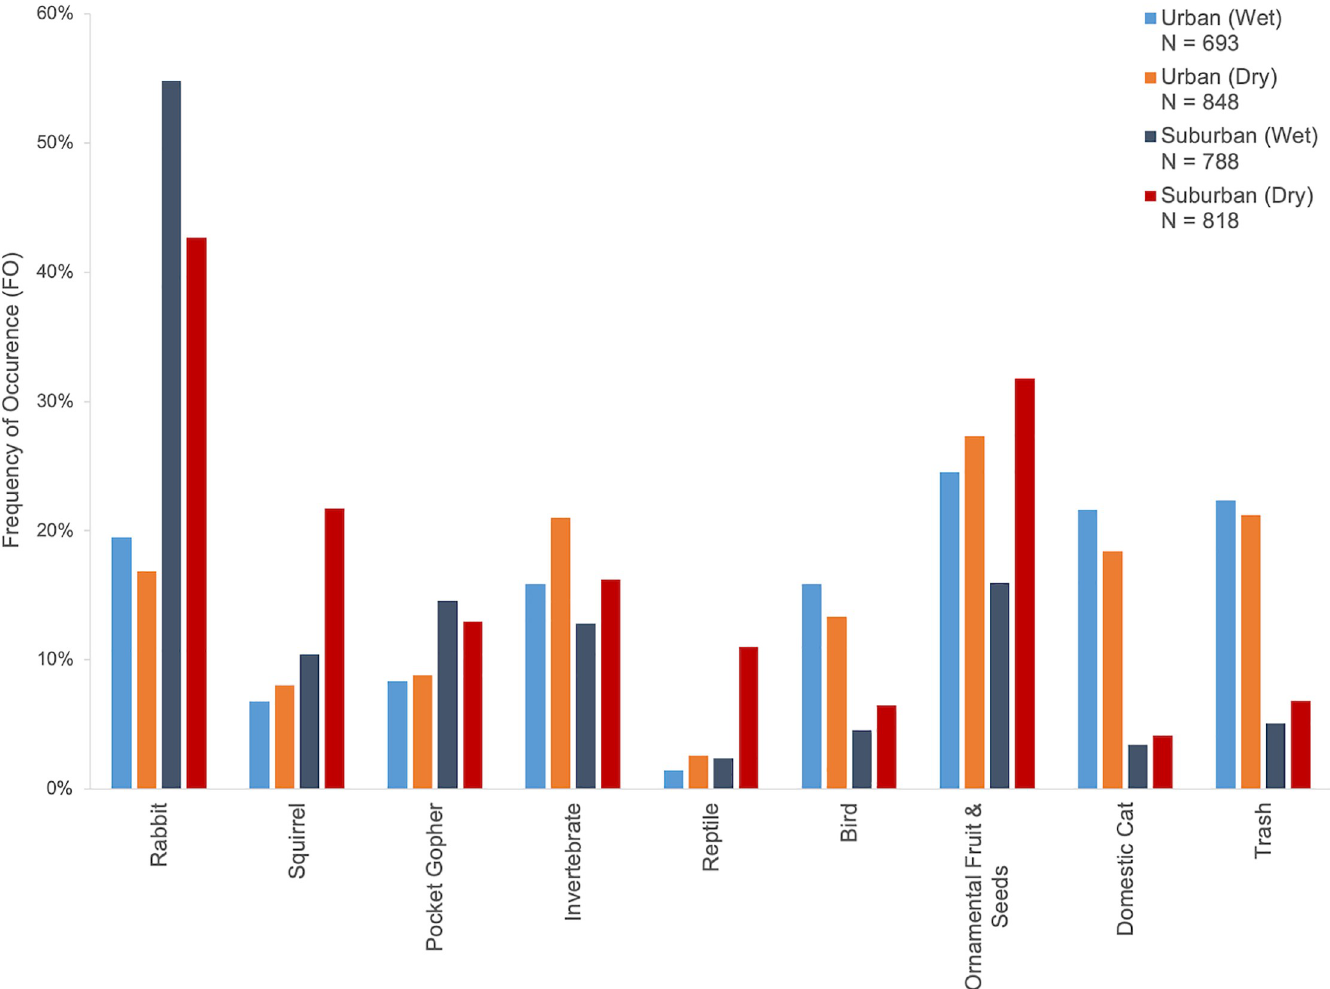
Fig 1. Frequency of occurrence of major diet items in coyote scats. “Urban” and “Suburban” refer to the study area in which the scats were collected and “Wet” and “Dry” refer to the season of collection. N refers to the total number of scats dissected during the two year sampling period. “Rabbit” includes cottontail rabbits. “Squirrel” includes California ground squirrels, western gray squirrels ( Sciurus griseus ), and unidentified squirrels (but does not include eastern fox squirrels). “Ornamental Fruit & Seeds” includes plant species not native to California (e.g., figs, palms, and grapes). “Trash” includes items associated with humans (e.g., tin foil, plastic, paper, etc.). Refer to S1 Table for a complete list of all food